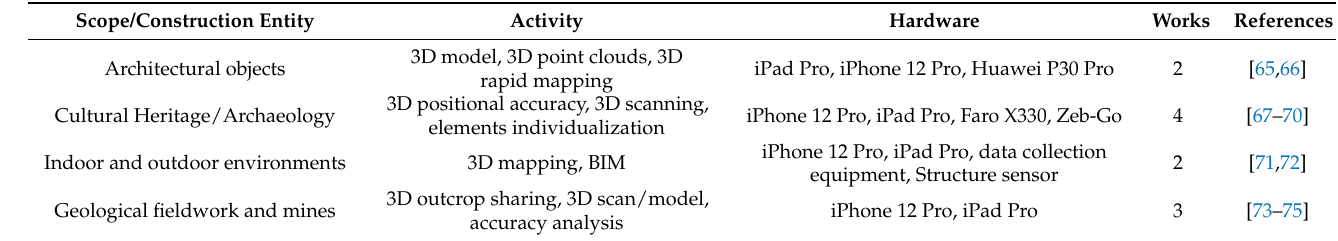
Table 2. Overview of the scope, topics, hardware used, and quantification of research works on “LiDAR” and “iPad”.